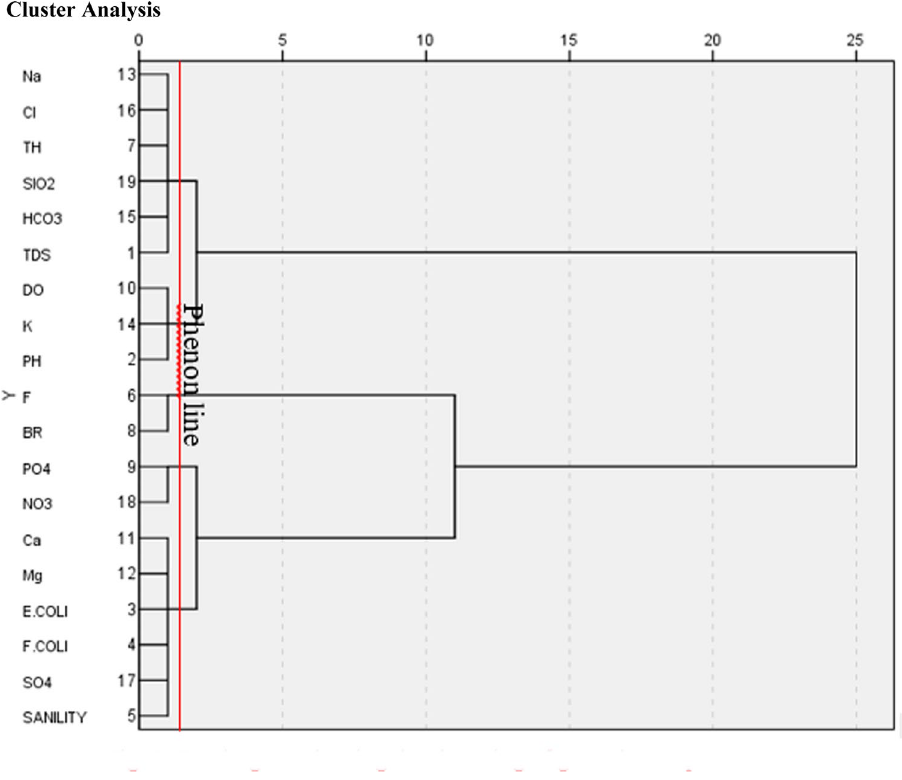
Fig. 5 Dendrogram showing the clustering of groundwater